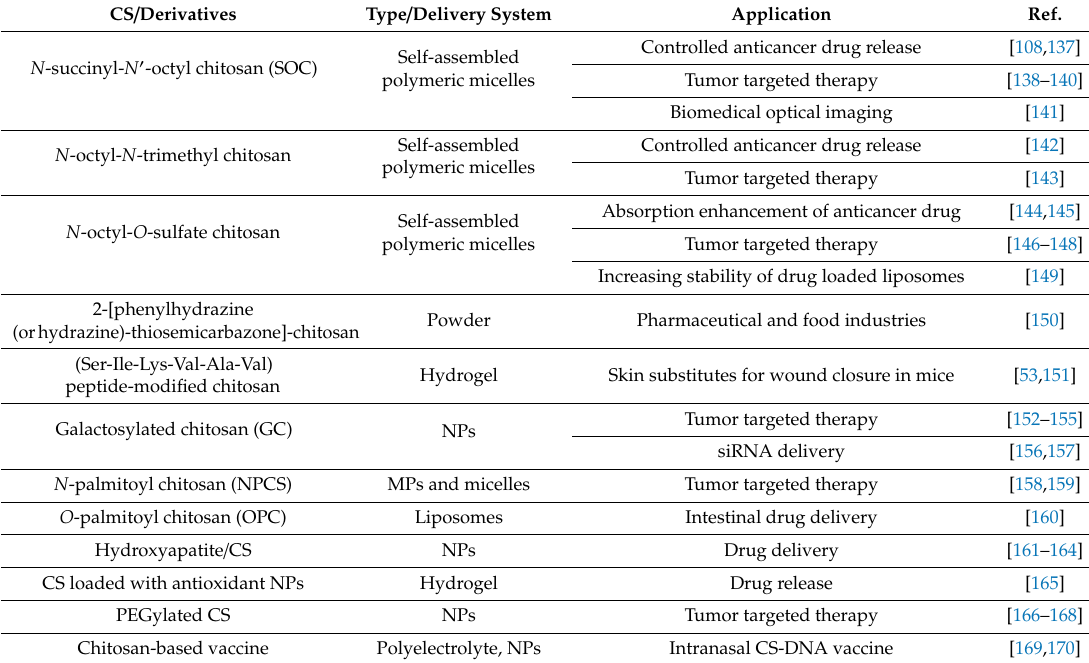
Table 1. Chitosan and its derivatives for drug delivery. NPs: